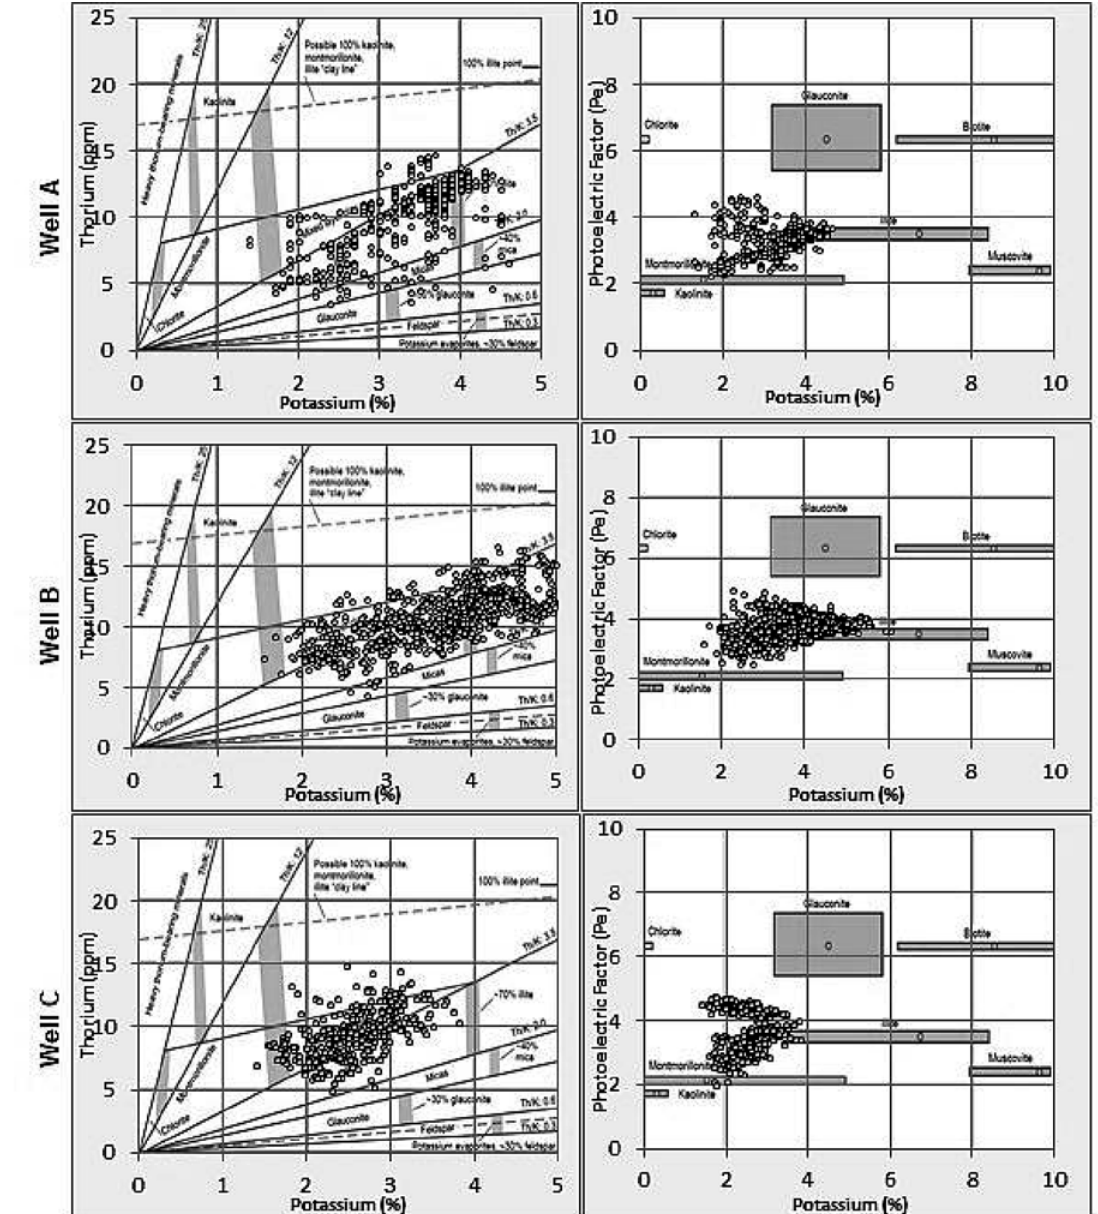
Fig. 2. Clay minerals identification cross plots of zones with Gamma-ray above 50